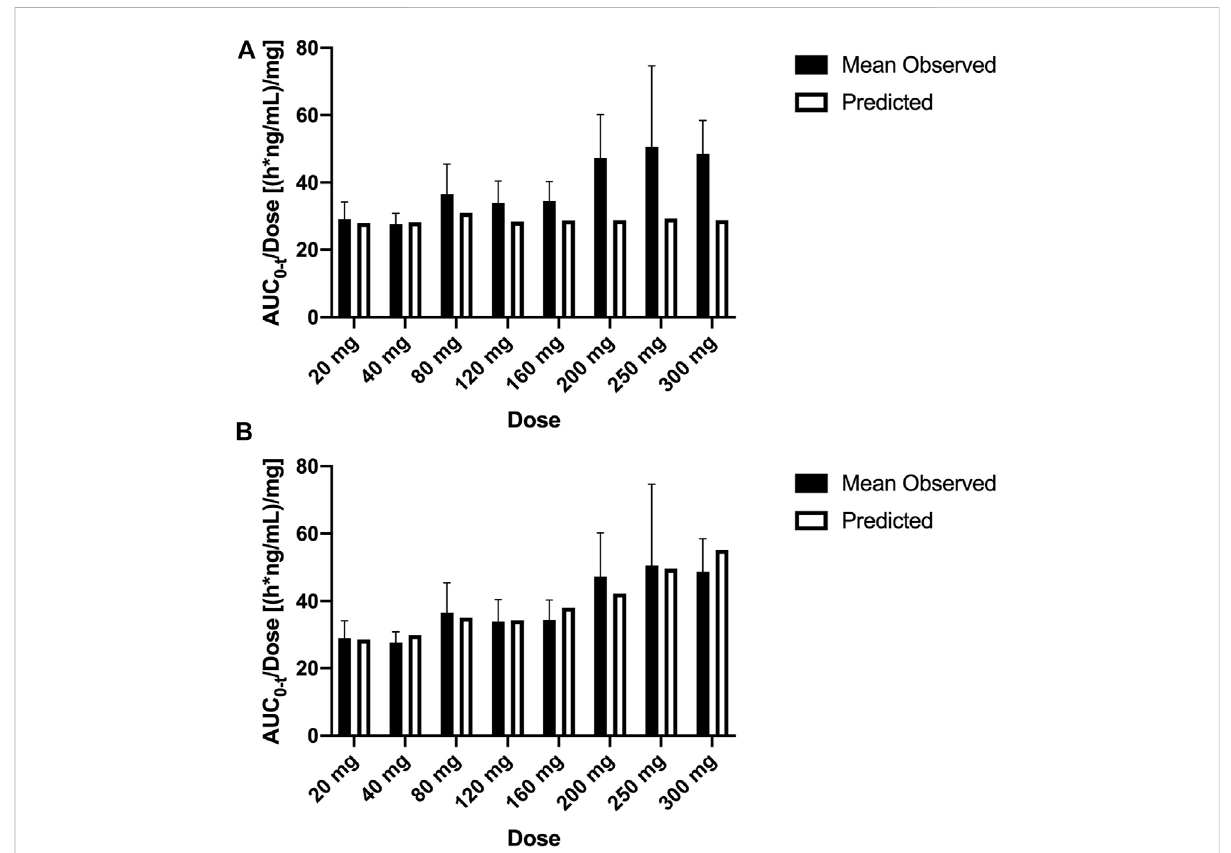
FIGURE 4 Mean observed (±SD) and predicted dose-normalized AUC 0-t for single ascending doses with the original PBPK model (A) and updated PBPK model (B) . AUC 0-t , area under the plasma concentration – time curve from 0 to the last measurement time; PBPK, physiologically based pharmacokinetic.